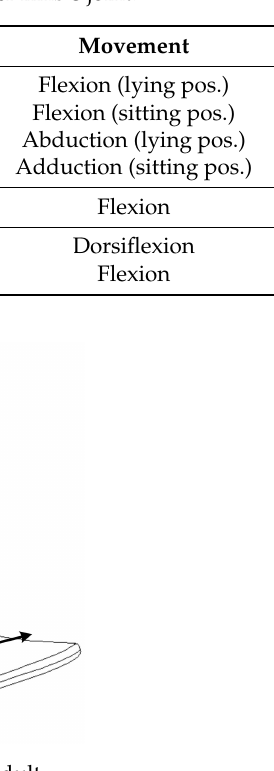
Table 1. The range of motion of human lower limb’s joint.